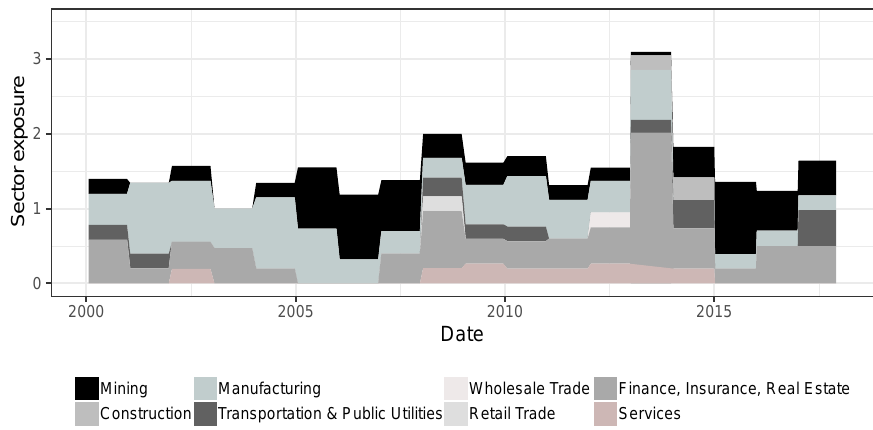
Figure 5. Yearly sector exposure based on the PCA selection process from January 2000–December 2017. Sector short positions are for illustrative purposes not included. Source: authors’